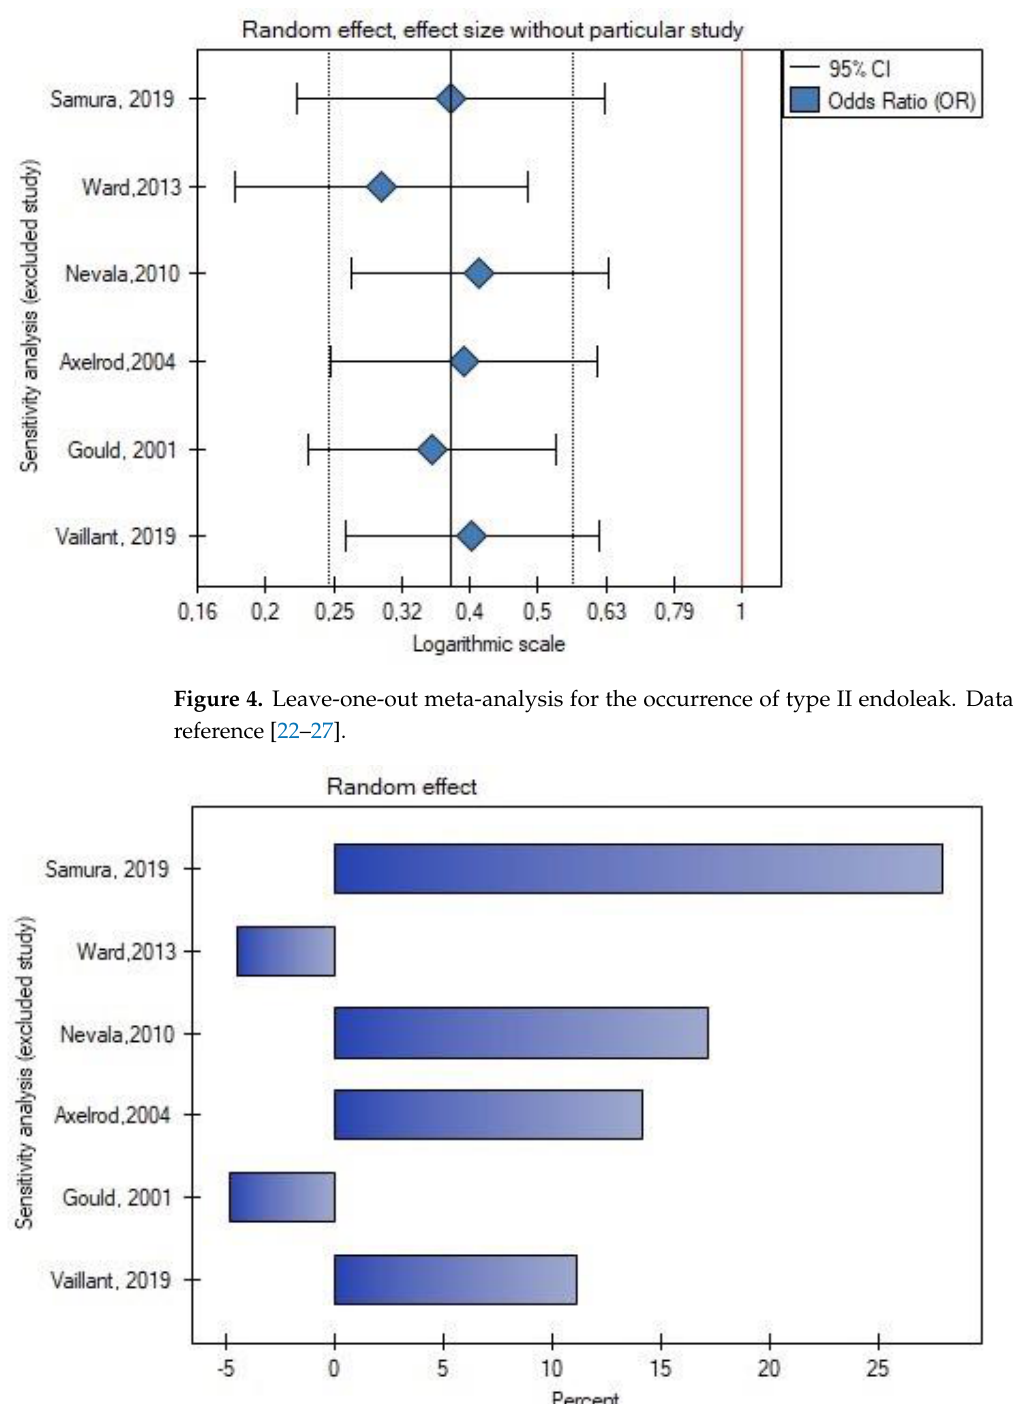
Figure 5. Leave-one-out meta-analysis with random effect and change of precision for the occurrence of type II endoleak. Data referred from reference [22 – 27].